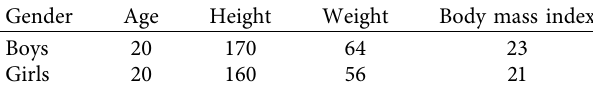
Table 2: Basic data of research